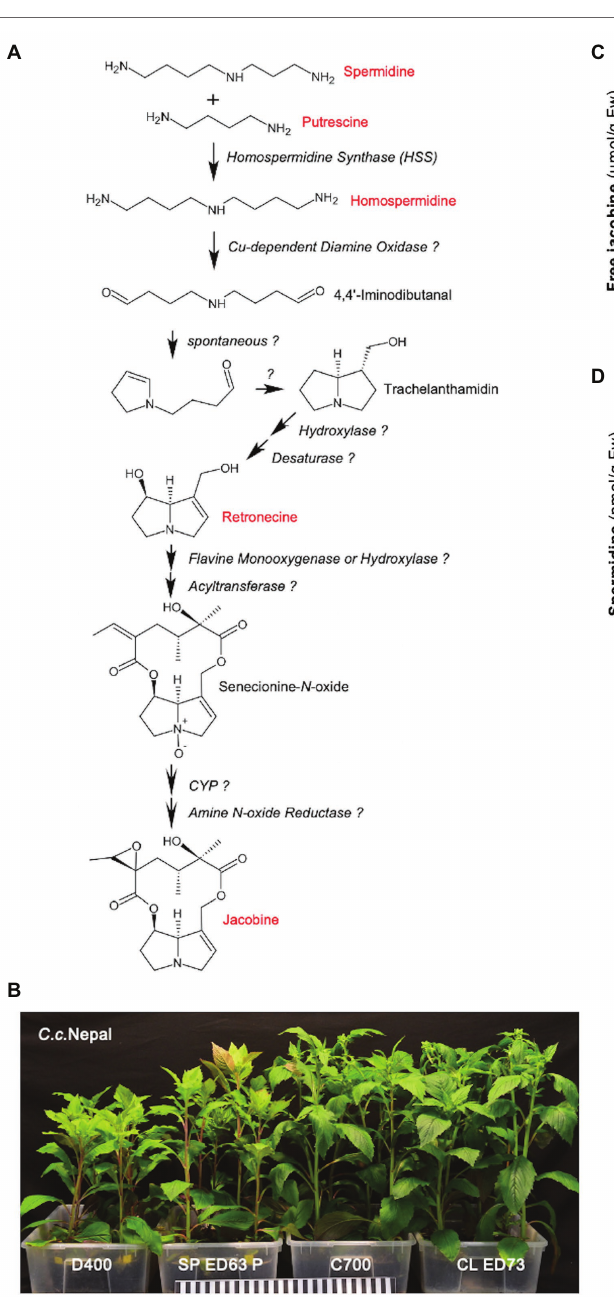
FIGURE 1 | Leaves of Crassocephalum crepidioides , but not of Crassocephalum rubens , accumulate jacobine, which is promoted by growth on low nitrate substrate. (A) Tentative PA biosynthetic pathway required for the biosynthesis of jacobine (modified from Schramm et al., 2019b). PAs and up-stream precursors analyzed are marked in red. Unknown enzymes are labeled with? (B) Representative 8-week-old plants of the Crassocephalum crepidioides ecotype Nepal, grown on the indicated growth substrates in long-day growth conditions at 22 ± 2 ° C. (C) Amount of free jacobine in leaves of 8-week-old plants of Crassocephalum crepidioides and Crassocephalum rubens (grown as in B ) measured from six plants. Nutrient analyses showed that D400 and SP ED63 P are low in nitrate, C700 has medium nitrate and CL ED73 has high nitrate levels (soluble nitrate concentrations are shown in the legend; for details on all nutrients see Supplementary Table 1 ). (D) Amounts of the polyamines spermidine, putrescine, and homospermidine in leaves of plants grown as in (B) . The columns and bars represent the average and standard error of six independent replicates. Statistically significant difference at p ≤ 0.05 of results between substrates (within individual species) is indicated with different letters and was determined with one-way ANOVA followed by Tukey’s HSD test [jacobine: C.c. Nepal (ANOVA F 3,20 = 7.251, p = 0.002), C.c. Ile-Ife (ANOVA F 3,20 = 11.199, p = 0.0002); spermidine: C.c. Nepal (ANOVA F 3,20 = 8.482, p = 0.001), C.c. Ile-Ife (ANOVA F 3,20 = 37.897, p < 0.0001), C.r. Burkina Faso (ANOVA F 3,19 = 9.375, p = 0.0005), C.r. Mali (ANOVA F 3,20 = 23.154, p < 0.0001); putrescine: C.c. Nepal (ANOVA F 3,20 = 31.576, p < 0.0001), C.c. Ile-Ife (ANOVA F 3,20 = 31.307, p < 0.0001), C.r. Burkina Faso (ANOVA F 3,19 = 8.016, p = 0.001), C.r. Mali (ANOVA F 3,20 = 42.433, p < 0.0001); homospermidine: C.c. Nepal (ANOVA F 3,20 = 0.226, p = 0.877), C.c. Ile-Ife (ANOVA F 3,20 = 10.980, p = 0.0002), C.r. Burkina Faso (ANOVA F 3,19 = 16.822, p < 0.0001), C.r. Mali (ANOVA F 3,20 = 14.753, p <